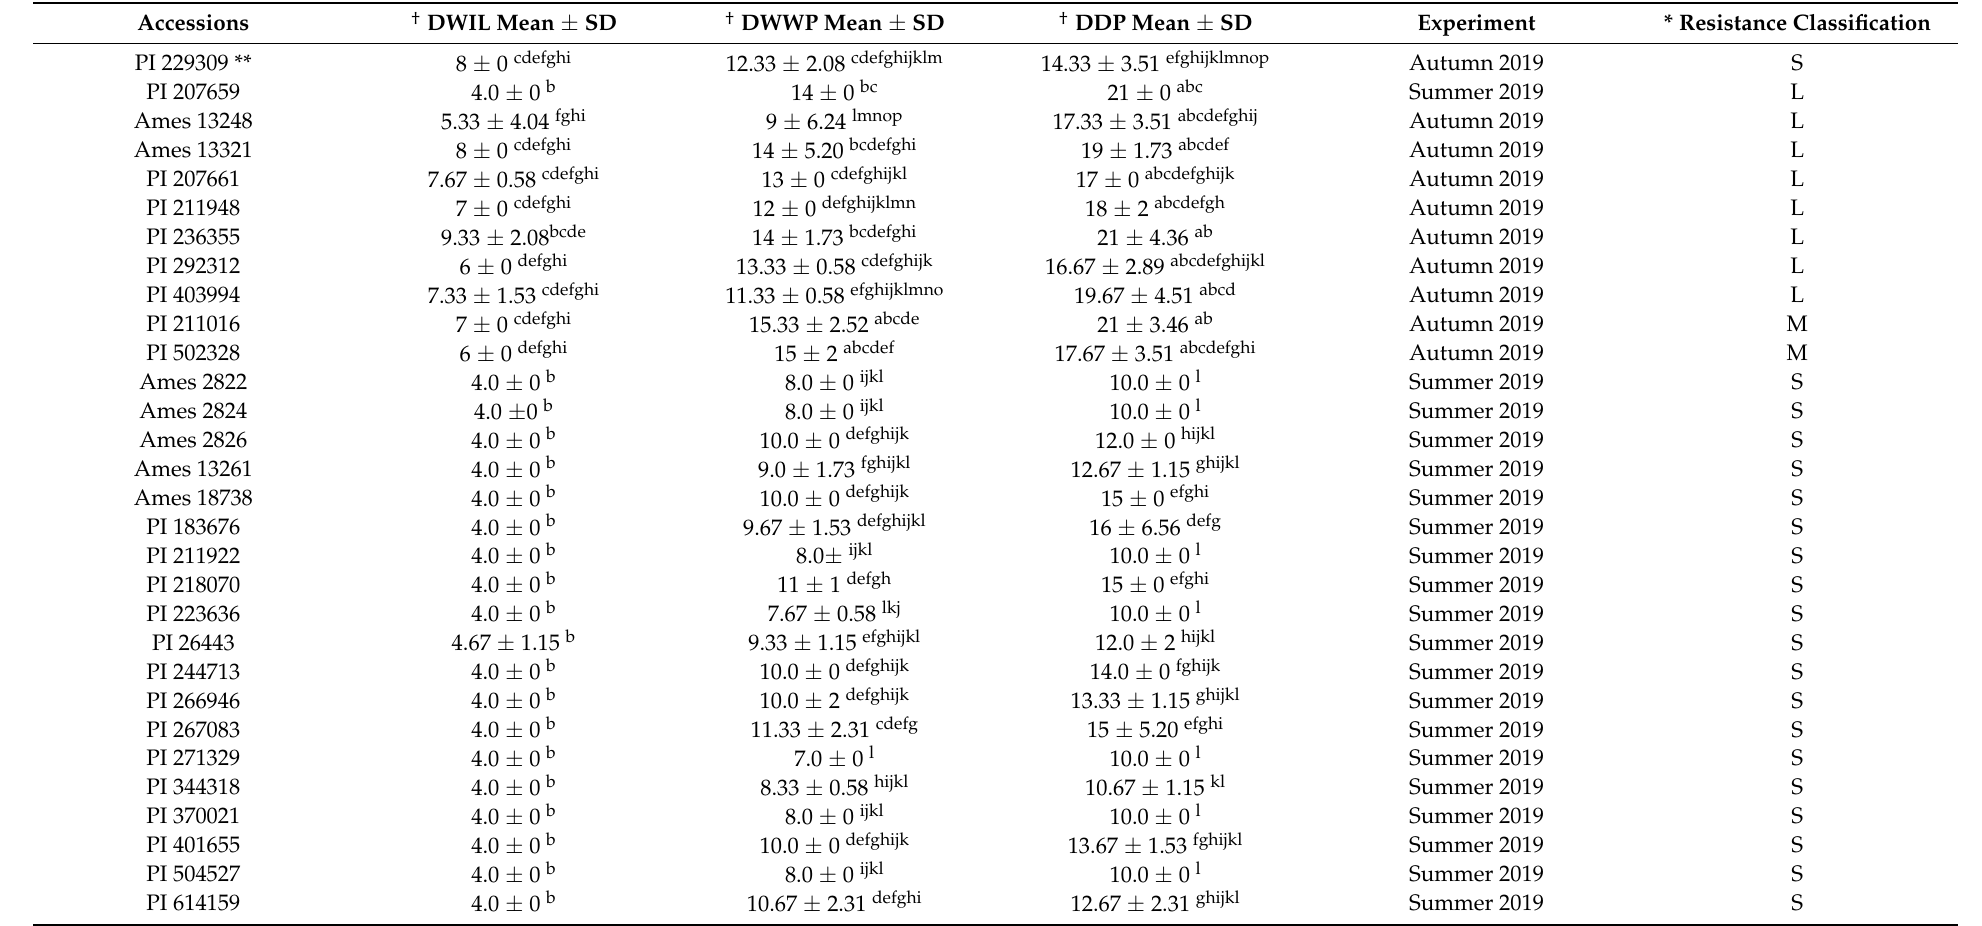
Table 2. Mean disease scores of melon and cucumber lines inoculated with E. tracheiphila Hca1-5N in one season screening test (Summer 2019 or Autumn 2019)